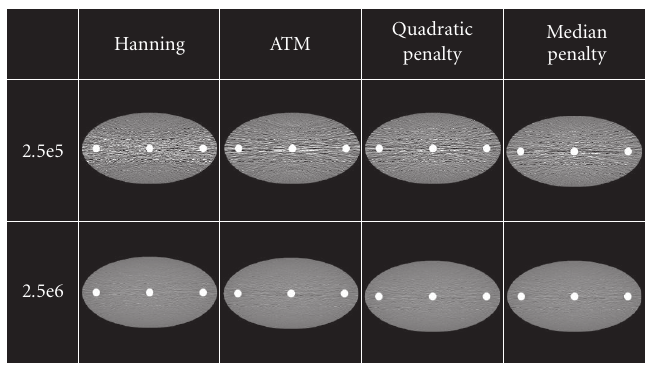
Figure 2: The left column illustrates reconstructions by FFBP employing a Hanning filter with cuto ff 0.8 times the Nyquist frequency. The second column illustrates reconstructions by FFBP after sinogram smoothing by the ATM filter method and o ff -focal radiation deconvolu- tion. The third column illustrates reconstructions by FFBP after sinogram restoration by the quadratic penalty method. The final column illustrates reconstructions by FFBP after sinogram restoration by the median penalty method. Exposures are listed at left. The window width is 400 and the level is